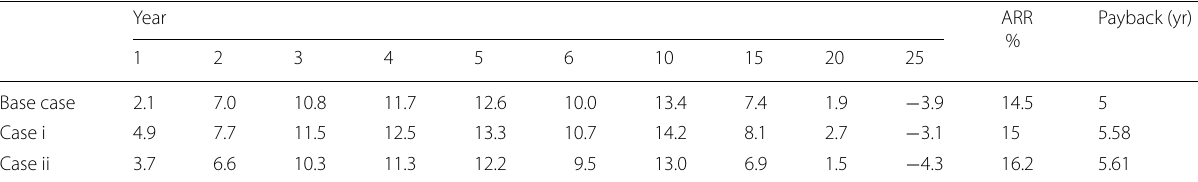
Table 1 Illustration of after-tax profits (million) using ARR and payback methods